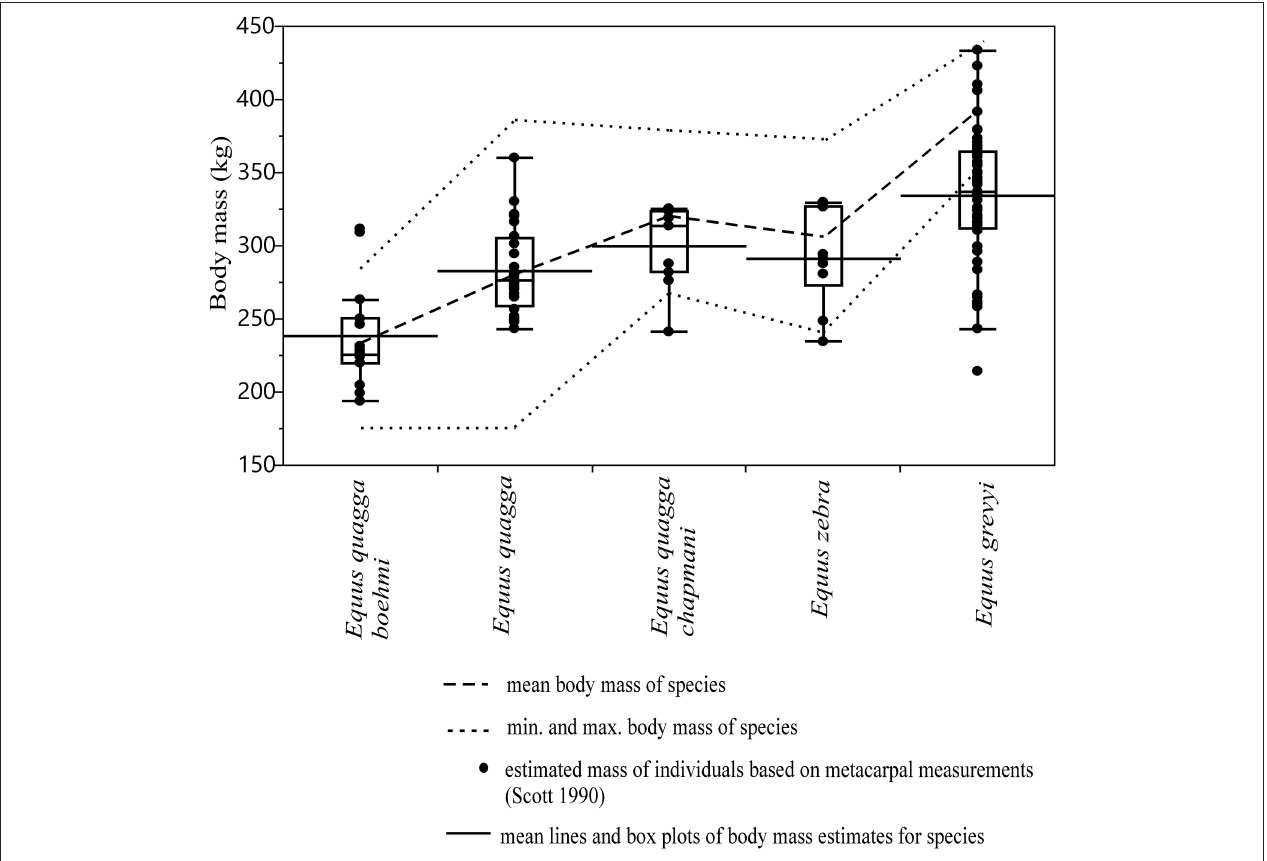
FIGURE 4 | Box plots and mean lines of body mass estimates of extant zebras based on metacarpal III measurements (MC2, MC4, and MC6 of Scott, 1990) compared with reported mean, minimum and maximum body mass marked as dashed lines. Percent differences of the mean estimated body mass to mean reported body mass are: 0.89% for E. quagga , 2.29% for E. quagga boehmi , 4.8% for E. zebra , 6.3% for E. quagga chapmani and 13.4% for E. grevyi . The central line in the box plot indicates the median, the box covers the interquartile range (IQR) and the upper and lower whiskers are 1.5*IQR. In addition, a mean line is shown as a horizontal line extending outside the vertical limits of the